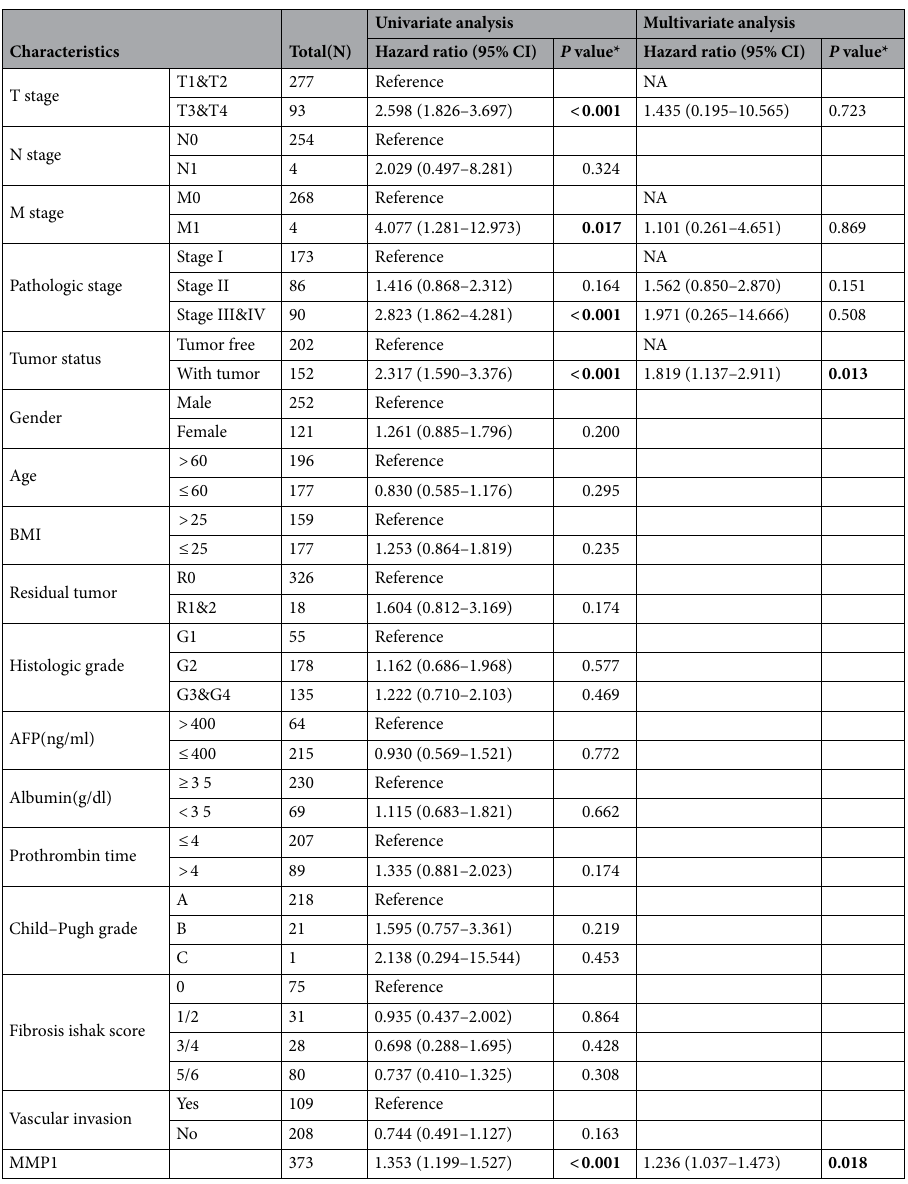
Table 4. The univariate and multivariate analysis for the OS (TCGA-LIHC). OS overall survival, CI confidence interval, NA reference group or could not be evaluated. *Compared with each group